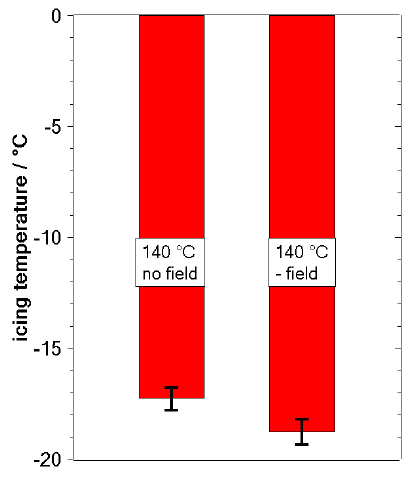
Figure 6. Comparison of the freezing temperature on P(VDF-TrFE)-coated glass after thermal treatments of the same sample at 140 °C for the cases with no electric field applied and with a negative electric field